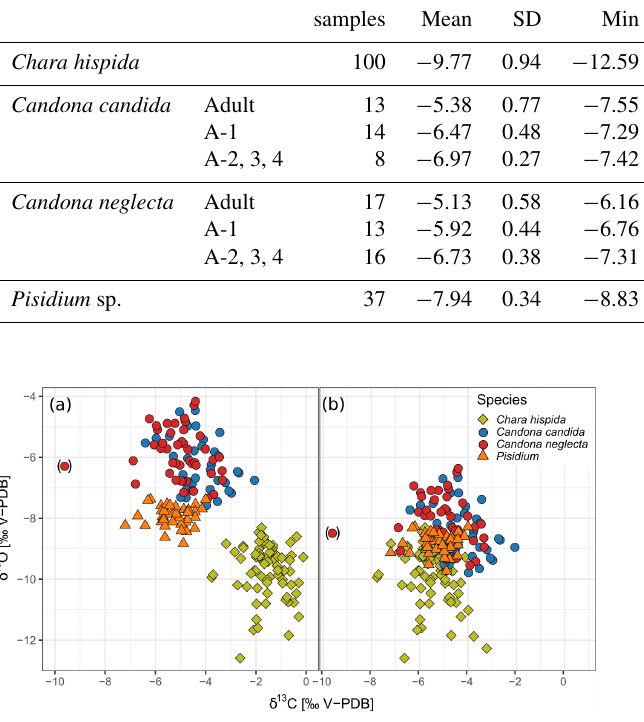
Figure 7. Isotopic composition of calcite encrustations from dif- ferent types of Chara samples. Internodes, branchlets and fine cal- cite were collected from living Chara , “subfossil fragment” refers to fragments of Chara encrustations taken from surface sediments. (a) δ 18 O and δ 13 C of Chara hispida samples from Lake Lock- nesjön. (b) δ 18 O and δ 13 C of Chara hispida and Chara aspera sam- ples from Lake